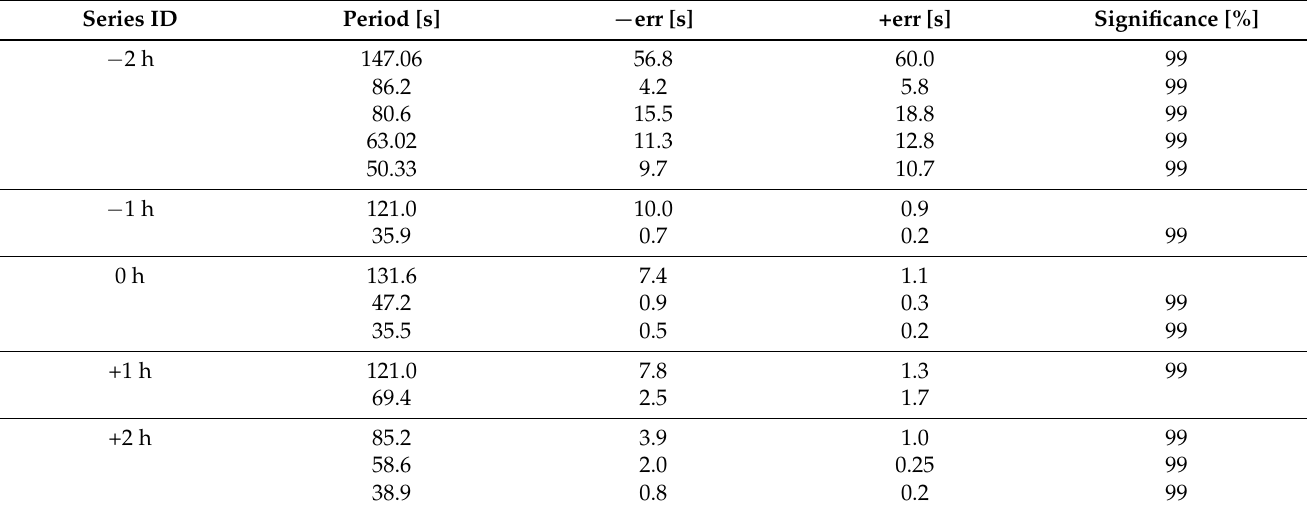
Table 1. Summary of detected periods on the date of the earthquake. Periods are measured from the integrated version of the 2D Hybrid map (bottom marginal panels) in Figure 2. Columns: series part with respect to earthquake beginning time, detected periods, lower and upper errors.